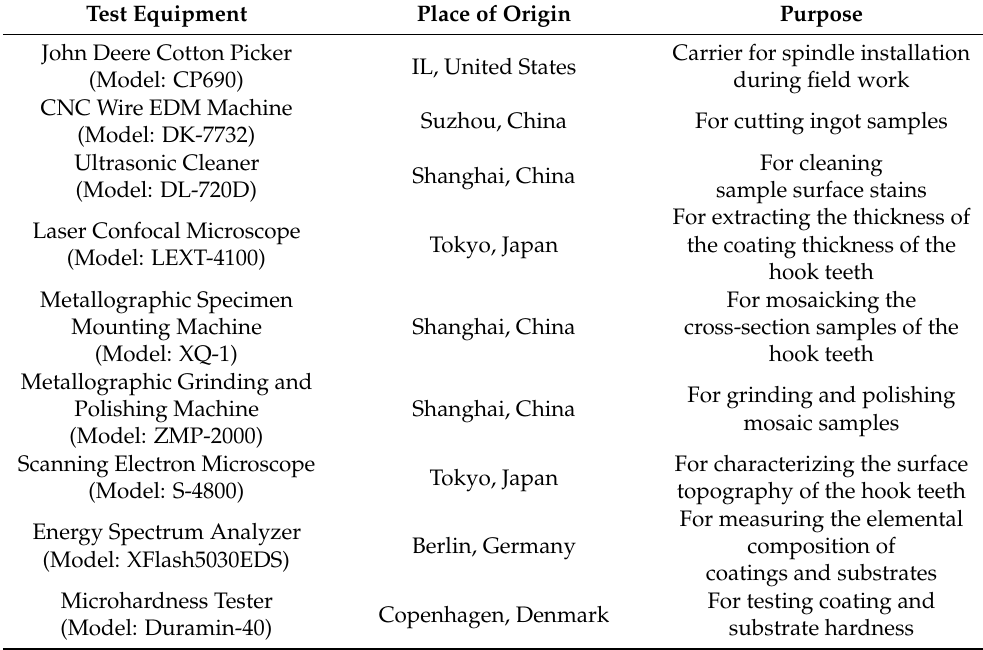
Table 1. Test equipment.